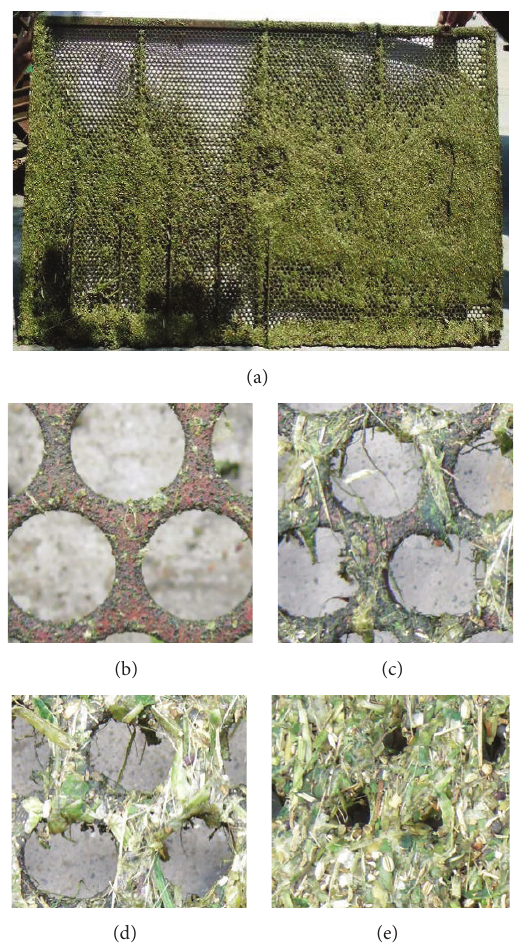
Figure 1: Rape threshing materials adhere to the cleaning screens of combine harvesters resulting in